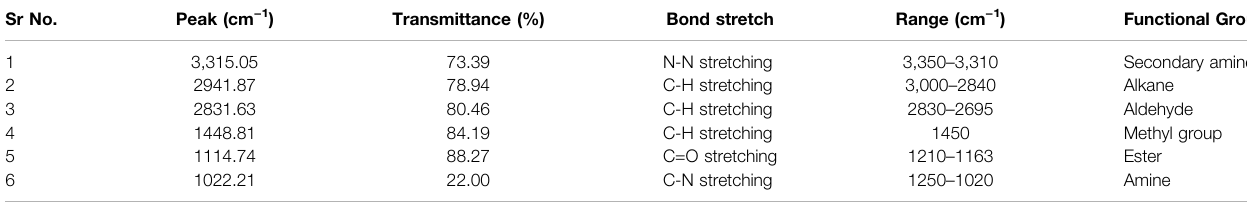
TABLE 4 | FTIR of Cucumis melo var. agrestis biodiesel. Sr